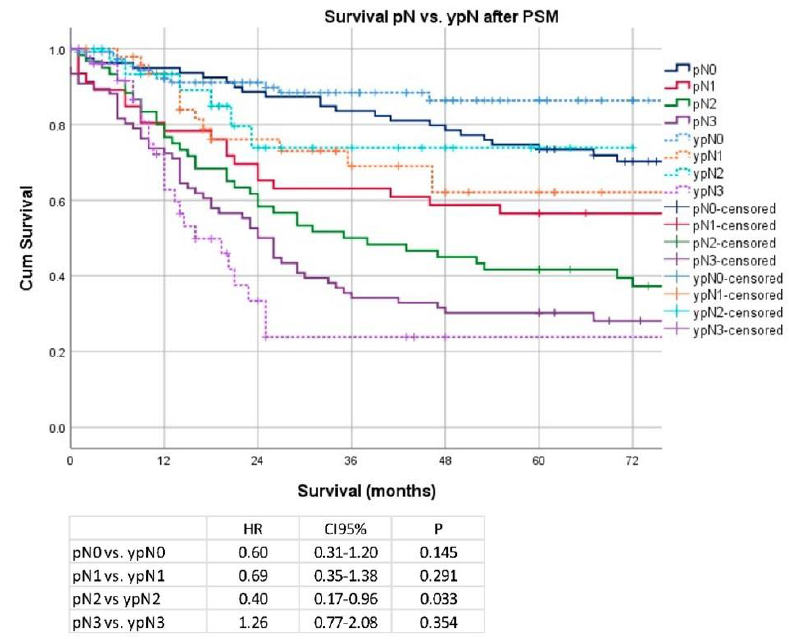
Figure 6. Kaplan–Meier analyses according to pN7ypN stages after PSM. Figure 6. Kaplan – Meier analyses according to pN7ypN stages after PSM. Table 5. HPR rates (according to Becker) depending on yUICC stage. In a further subgroup analysis of the PSM-cohort, histopathologic response rates were analyzed. In UICC stage I, the proportion of responders was highest at 17.8%, in yUICC I yUICC II yUICC III p < stage II it was 8.8%, and in stage III it was negligible at 3.5%. Data are shown in Table 5.